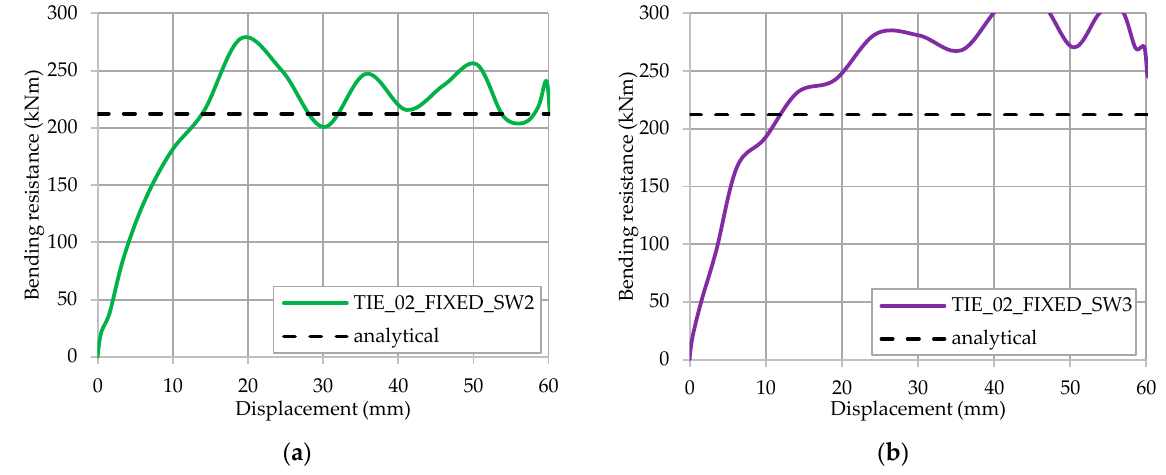
Figure 21. Bending resistance of the fixed beam for a fully tied shear connection: ( a ) SW2; ( b ) SW3.